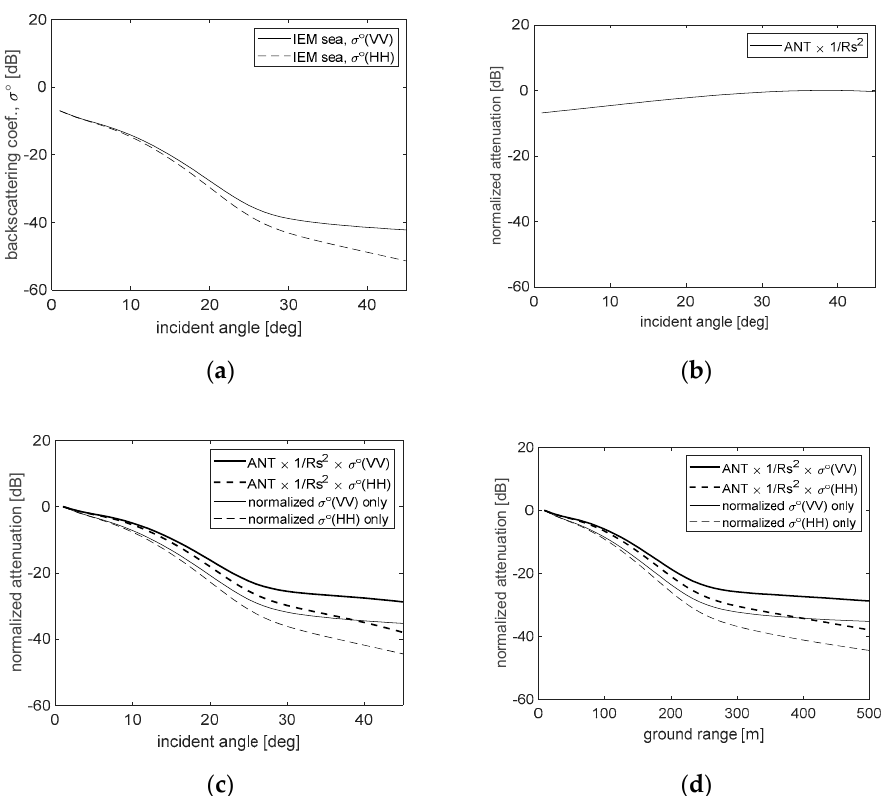
Figure 7. The property of the attenuation of sea clutter signal in each incident angle: ( a ) is the backscattering coefficients calculated by IEM; ( b ) is a normalized attenuation calculated by the antenna beam pattern and slant range; and ( c , d ) are the normalized total attenuations represented by the incident angle and ground range, respectively.